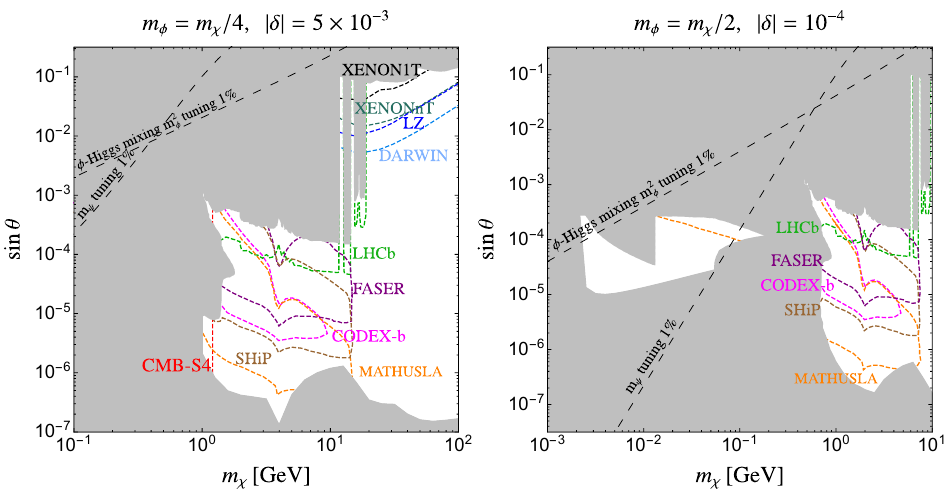
Figure 9 . Phenomenology of a dark sector weakly coupled to the SM. Both panels show the projected reach of future experiments as a function of the approximate DM mass, m (cid:31) , and the mixing between the dark sector scalar and the SM Higgs boson, sin (cid:18) . The gray shaded area sum- marizes current constraints, presented separately in (cid:12)gure 8. The reach for direct detection experi- ments [90{93], LHC-b [94], CODEX-b [94] as derived in [95], FASER [76, 96], MATHUSLA [97, 98], SHiP [99, 100] as derived in [98], and CMB Stage-4 (CMS-S4) [101] is shown. In every point of the plot (cid:1) is (cid:12)xed to reproduce the observed relic density. The remaining parameters are set to y = e i(cid:25)= 4 , m (cid:30) = m (cid:31) = 4 ( m (cid:31) = 2), and (cid:14) = 5 (cid:2) 10 (cid:0) 3 e i(cid:25)= 4 (10 (cid:0) 4 e i(cid:25)= 4 ) in the left ( right ) panel.